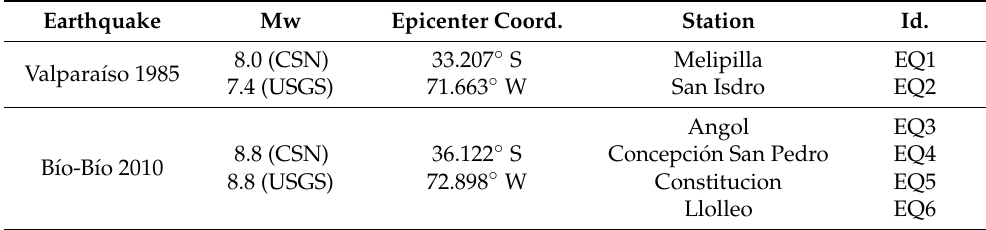
Figure 9. Response spectra of the two components of all the considered records matched with the displacement design spectrum (the same in the two directions) amplified by 17%. Table 4. Suite of 10 ground motions consistent with the Chilean response spectra in Figure 8.